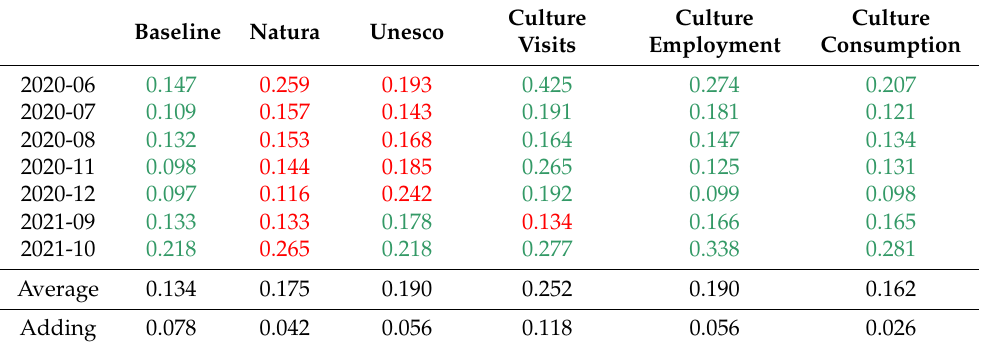
Table 1. Coefficients of determination for 7 months with at least 0.10 values in the baseline multiple regression, and further 5 regressions adding indicators of heritage and culture for the 20 countries under review. Culture Baseline Natura Unesco